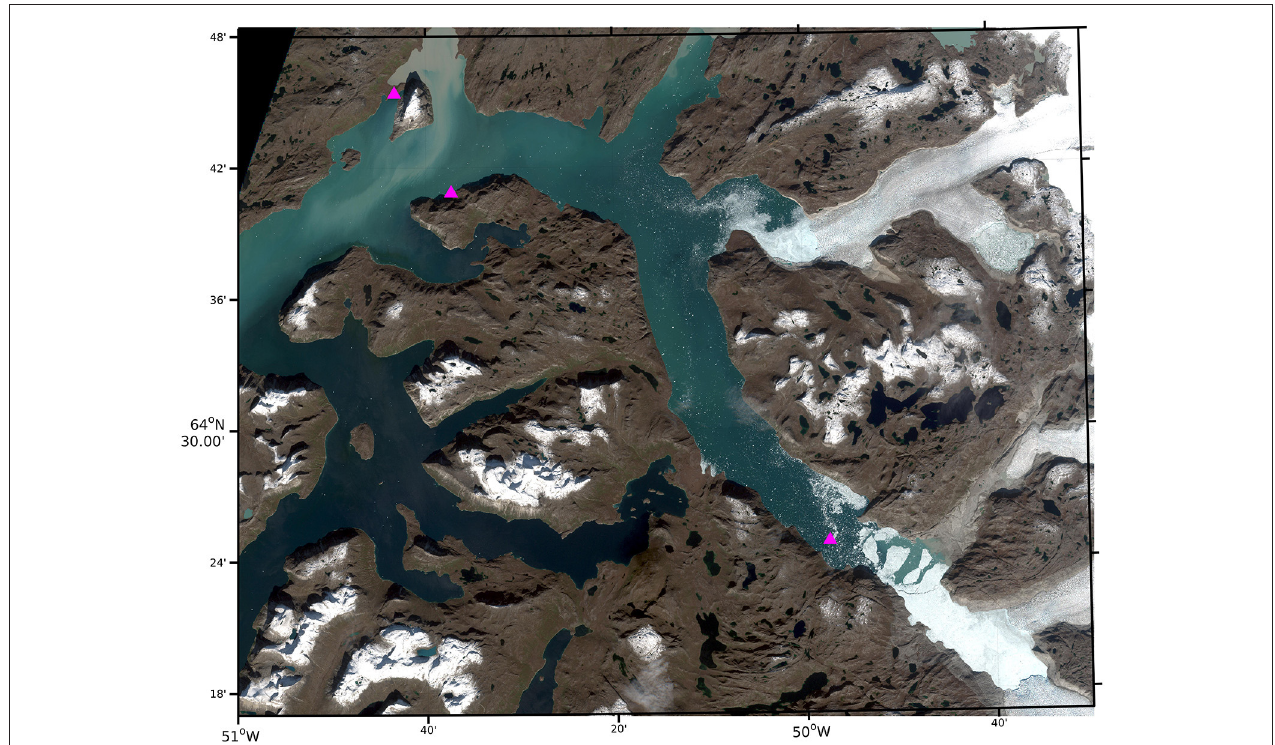
FIGURE 13 | Contrast-enhanced, color image of the inner Godthåbsfjord region acquired 10 September 2016. The positions of the 3 active EXITE beacons at the time of acquisition are shown by pink